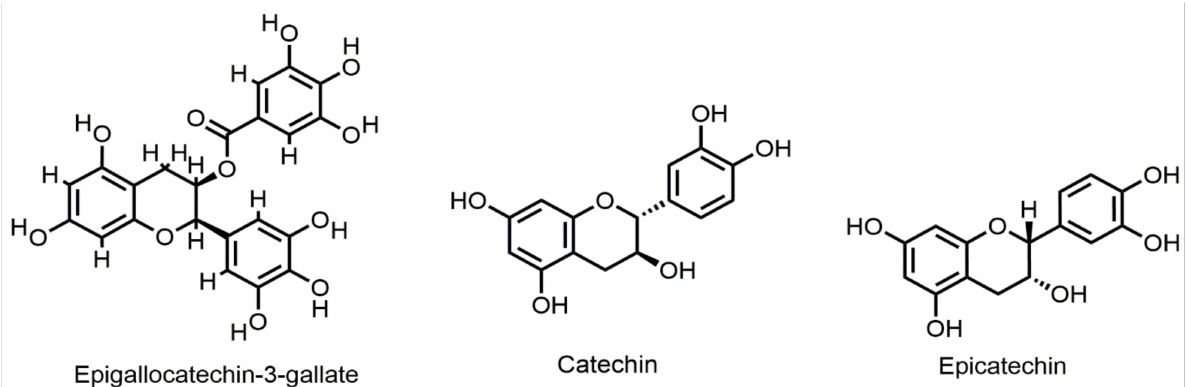
Figure 6. Selected chemical structures of flavan-3-ols targeting Bcl-2 in the p53